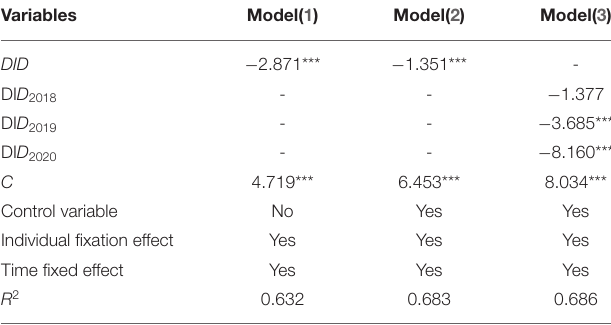
TABLE 3 | Full sample regression results.